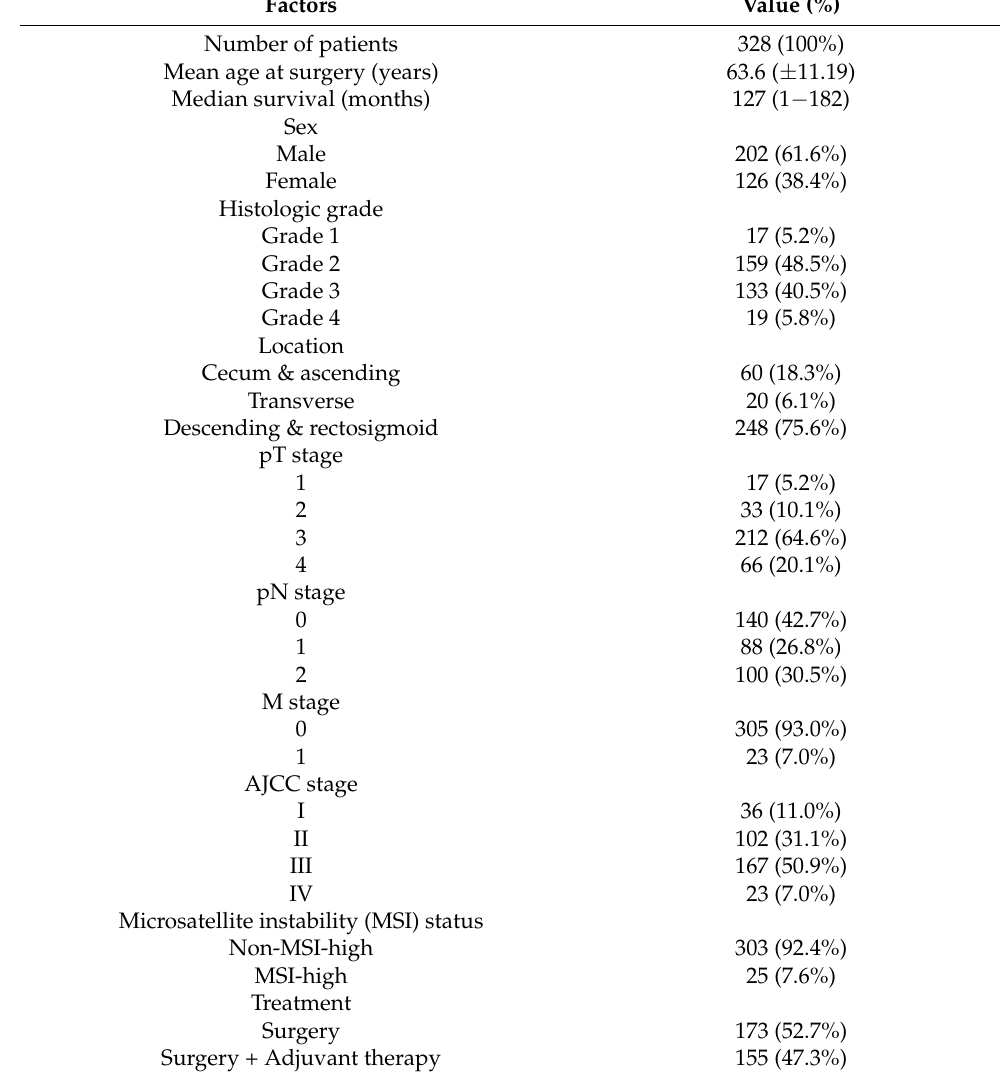
Table 1. Baseline characteristics of colorectal adenocarcinoma